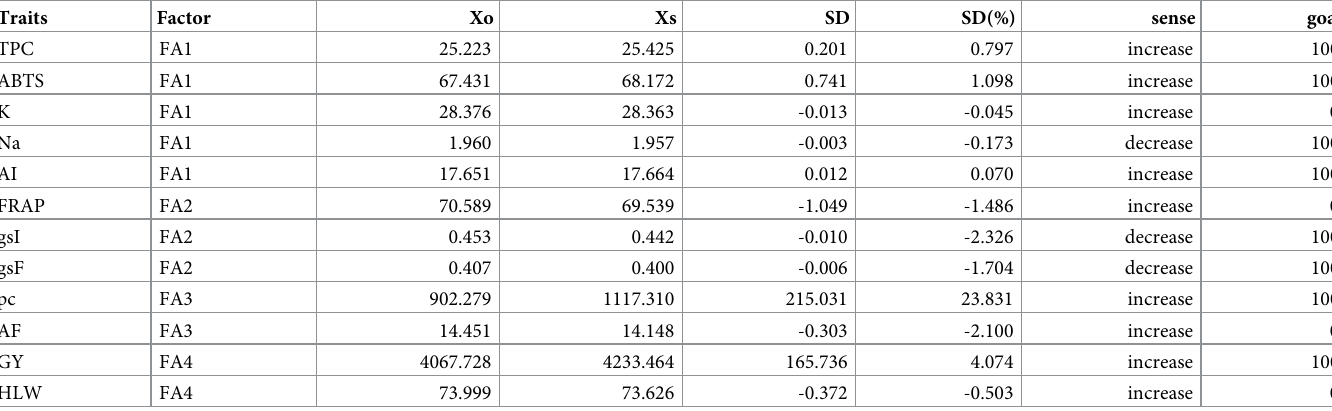
Grain yield (GY), hectolitre weight (HLW), initial liquid photosynthesis (AI) and final liquid photosynthesis (AF), initial stomatal conductance (gsI) and final